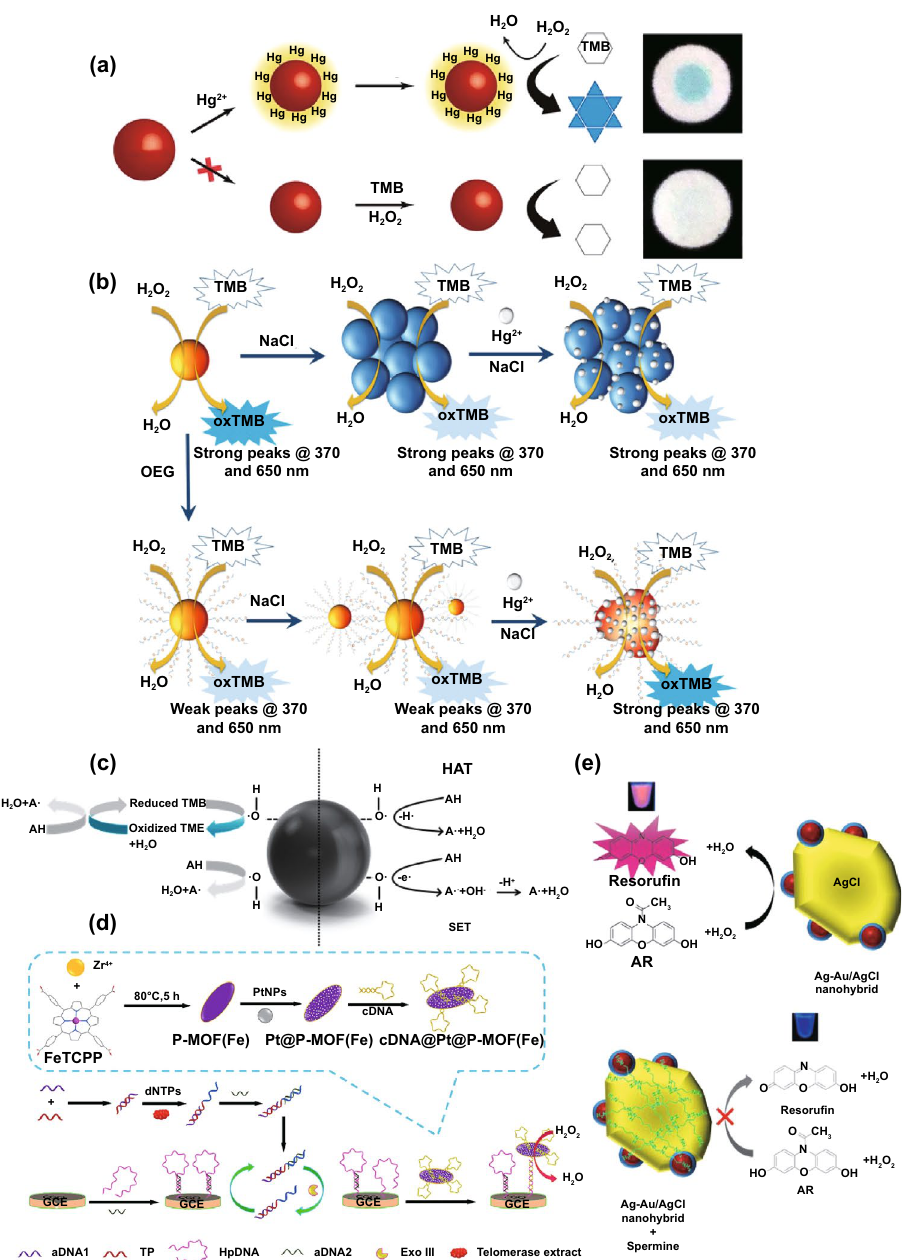
Fig. 7 a Detection progress of the Hg 2+ in distilled and tap water samples with AuNZ-PAD based on the TMB–H 2 O 2 catalytic reaction. b Principle of quantitative detection of Hg 2+ ions in seawater (3.5% NaCl) using OEG-AuNPs compared with that using bare AuNPs. c Detection principle of TAC based on the reaction between antioxidants and H 2 O 2 in the presence of Pt nanozymes as POD mimics. d Synthesis of cDNA@ Pt@P-MOF(Fe) as the signal probe for the analysis of telomerase activity. e Preparation of Ag-Au/AgCl nanohybrid with OXD-like and POD- like activity and the working mechanism of Spm detection. GCE Glassy carbon electrode, TP telomerase primer. Adapted from a Ref. [226], b Ref. [293]. c Ref. [301], d Ref. [302], e Ref. [303] with